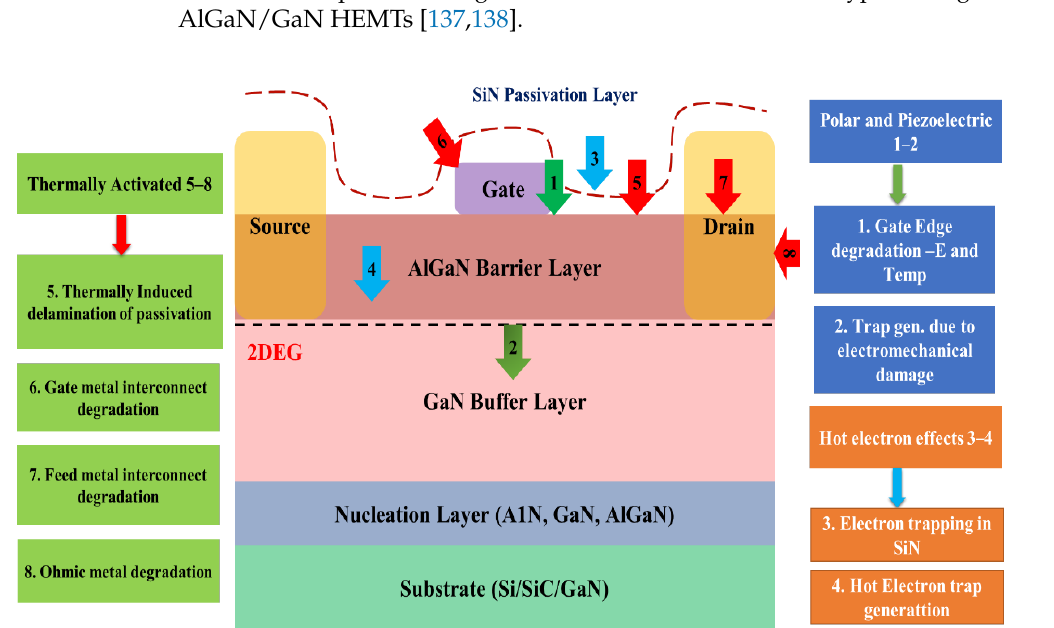
Figure 27. Several degrading problems affect AlGaN/GAN HEMTs with their origin. Reprinted with permission [138]. Copyright 2010, Cambridge University Press, and the European Microwave As- sociation.